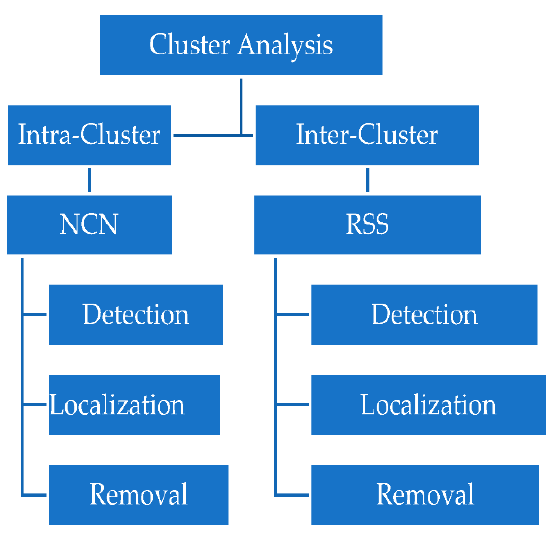
Figure 1. Detection, localization, identification and removal of spoofing attack.